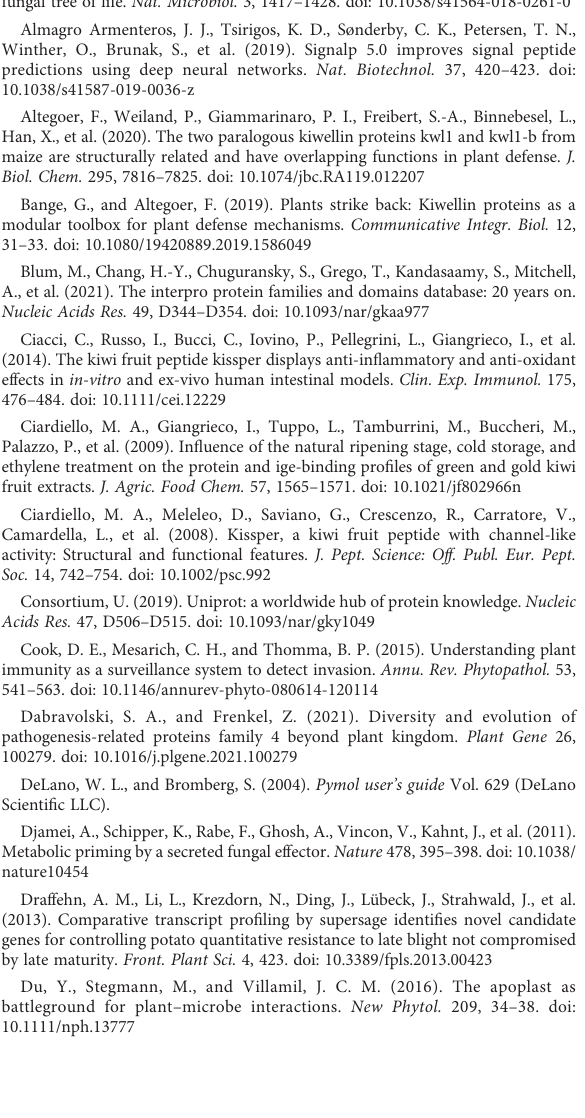
SUPPLEMENTARY DATA SHEET 1 Additional fi gures and detailed algorithmic description (PDF). chapter 1, S1